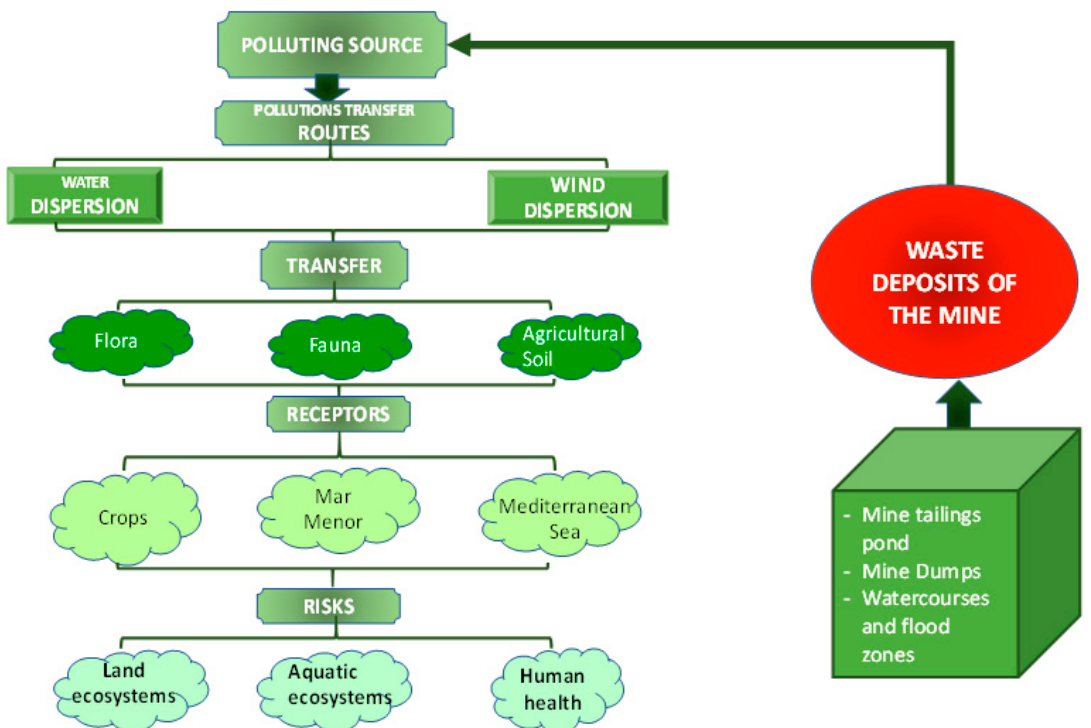
Figure 1. Conceptual model of the current state of contamination of Critical Abandoned Mining Areas (CAMAs): application to the Sierra Minera of Cartagena-La Unión case.